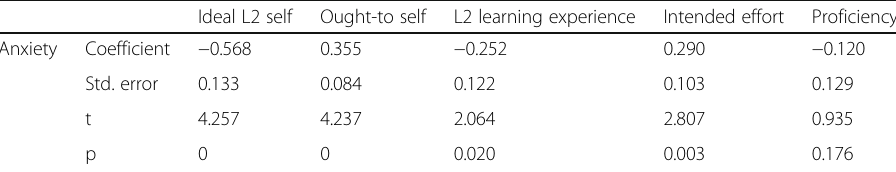
Table 4 First regression